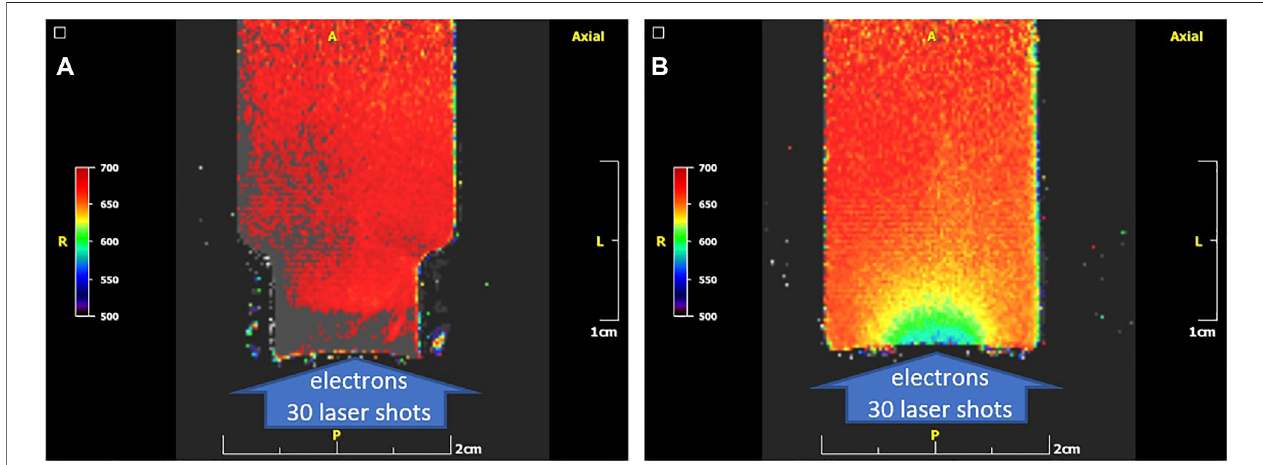
FIGURE10| TheT2colourparametricmaps(NIHpalette)ofthegel-vials (A) :T2colourparametricmapofa “ toptobottom ” irradiatedvialona45 TWlasersource with30shots.Herethecolourscaleisadjustedtobethesamewiththatofthe “ bottomtotop ” caseintherightfordirectcomparison.T2oftheirradiatedgel(mean grey/ red areas): 696 ± 13 ms. (B) : T2 colour parametric map of “ bottom to top ” irradiated vial on a 45 TW ZEUS laser source with 30 shots. Minimum T2 of the irradiated gel (blue/green areas): 583 ± 5 ms. Maximum T2 of irradiated gel (mostly red areas): 654 ± 5 ms. The difference in the images (A,B) denotes a suppression of dose response in the electron entrance region in the “ top to bottom ” arrangement most likely due to oxygen penetrating the thin foil there.